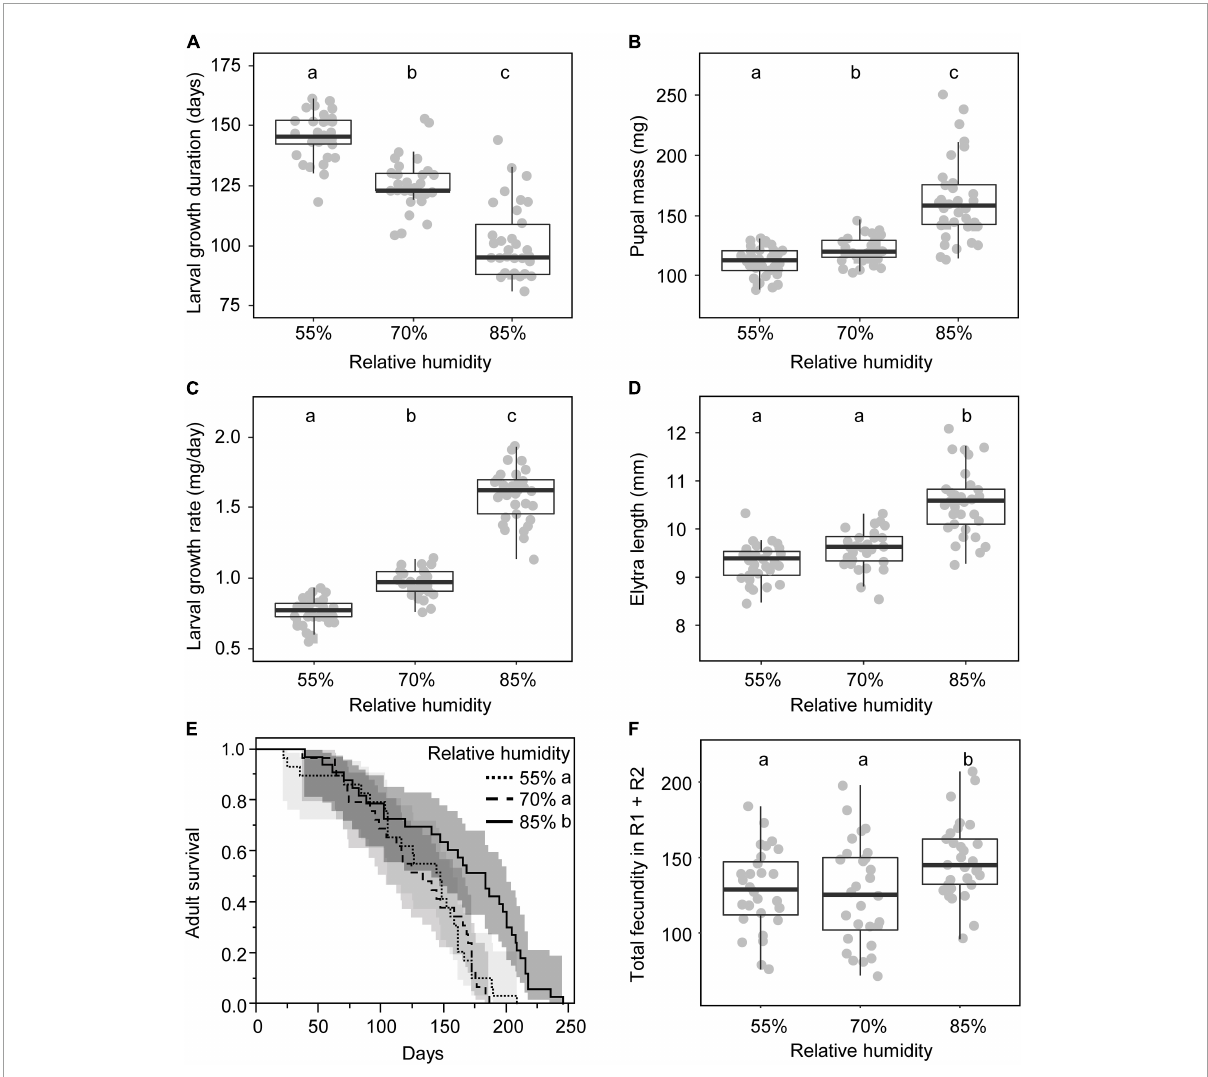
FIGURE1 Variation of life-history traits according to conditions of larval growth (relative humidity): growth duration (A) , pupal mass (B) , growth rate (C) , elytra length (D) , adult survival (E) , and total fecundity (sum of the number of eggs laid during the early and the late reproductive episode) (F) . Different letters indicate significant differences assessed by post-hoc tests [Tukey HSD in panels (A,D,F) , Kruskal–Wallis with Bonferroni correction in panels (B,C) and Log-rank pairwise tests in panel (E) ]. In panels (A–F) , gray dots are observations; box plots are median (bold lines), interquartile (boxes) and interdecile (error bars). In panel (E) , confidence interval curves are given for 95%.